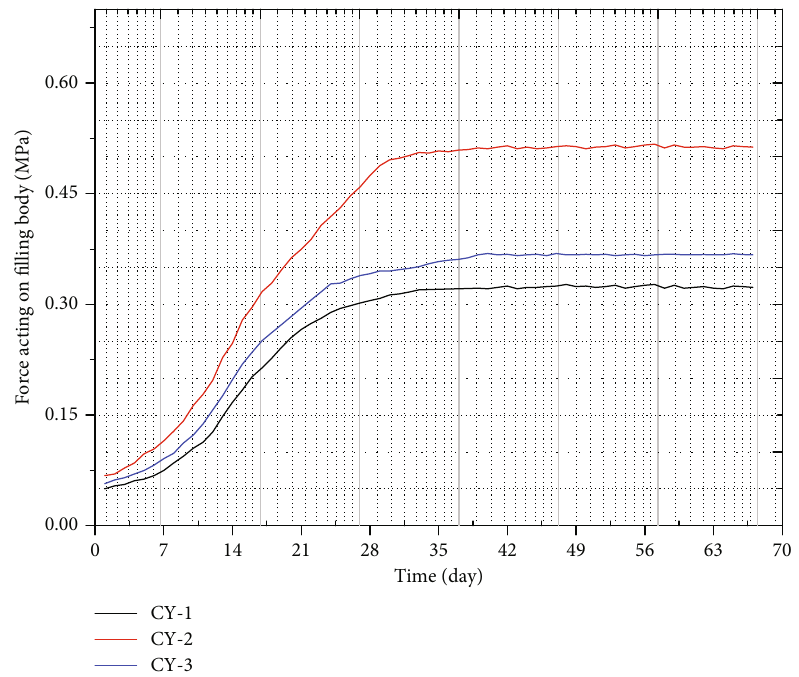
Figure 22: Force acting on the paste back fi ll body vs. the curing age.